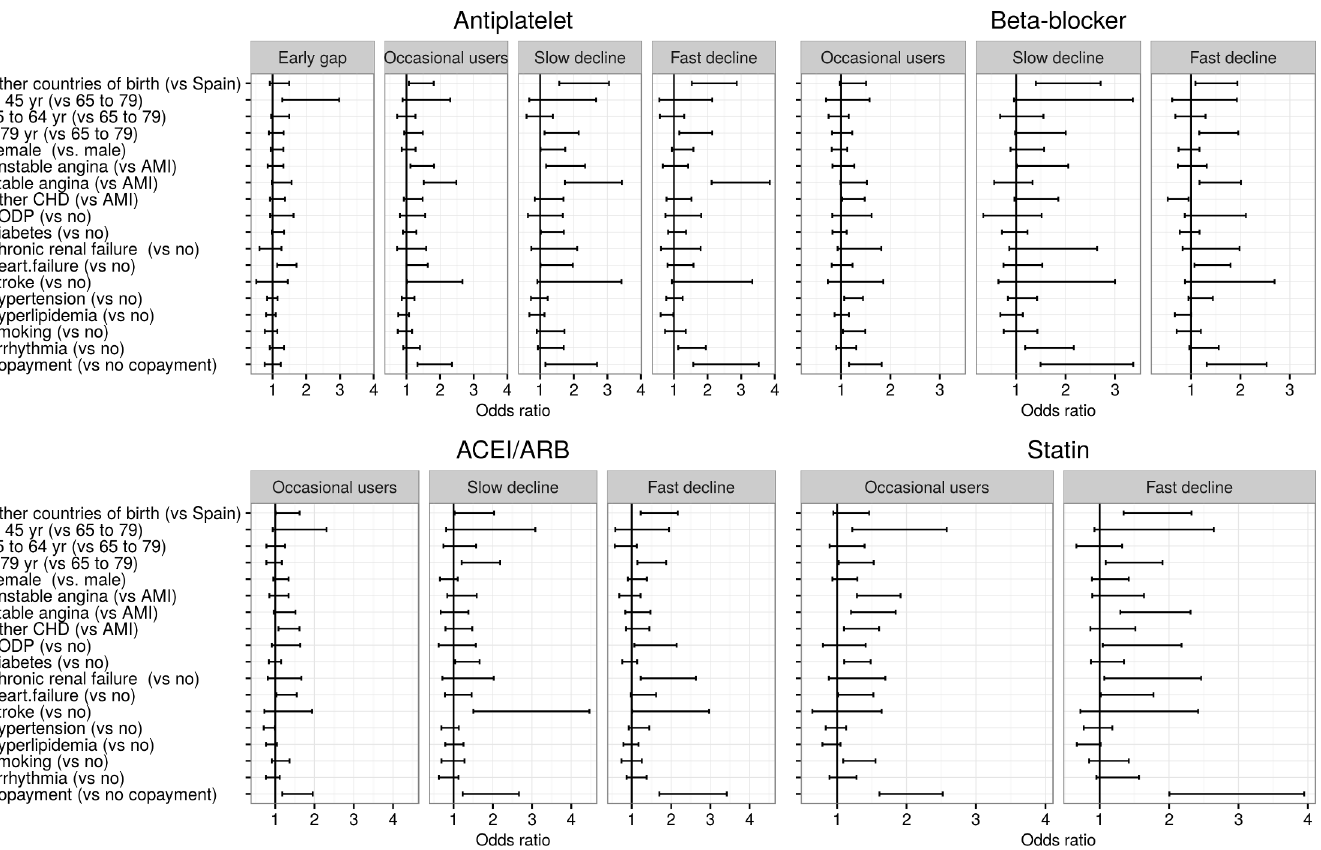
Fig 2. Predictors of poor or intermediate adherence trajectory groups. Multinomial logistic regression analysis. ACEI: angiotensin-converting enzyme inhibitors; ARB: angiotensin receptor blockers; CHD: coronary heart disease; AMI: acute myocardial infarction; COPD: chronic obstructive pulmonary disease. The reference category is the nearly-always adherent trajectory group. Estimates for peripheral vascular disease, cancer and dementia were not included due to their high random error.